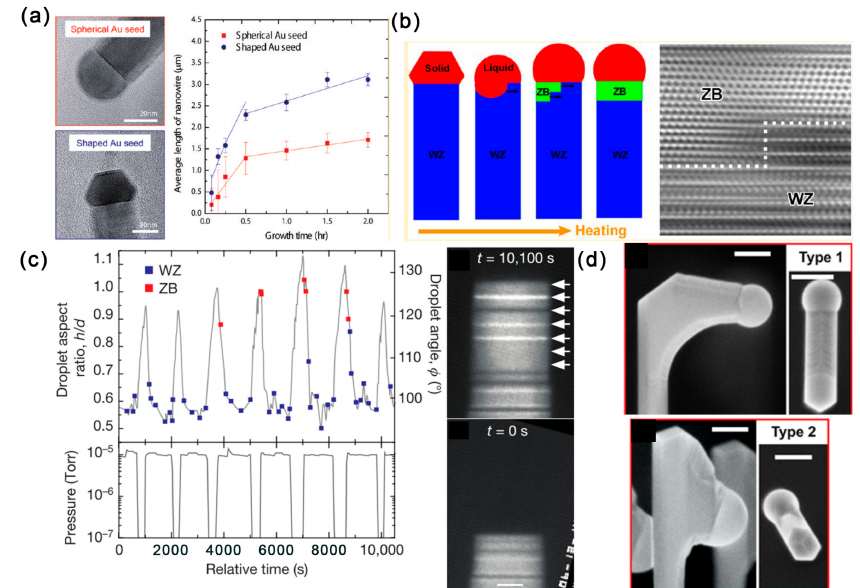
Figure 6. Influence of droplet NPs on the growth of III–V NWs. ( a ) Relationship between the average length and growth time of InAs NWs grown with spherical and shaped Au seed particles. Reproduced with permission [67]. Copyright 2012, American Chemical Society. ( b ) Role of Au particles in tailoring the nucleation and phases of InAs NWs at the liquid/solid interface. Reproduced with permission [68]. Copyright 2013, American Chemical Society. ( c ) Growth of a WZ GaAs NW containing multiple narrow ZB by controlling the AsH 3 pressure and the droplet morphology. Reproduced with permission [69]. Copyright 2016, Macmillan Publishers Limited. ( d ) Side- and top- view images of type 1 horizontal and type 2 downward-grown self-catalyzed GaAs NWs. Reproduced with permission [70]. Copyright 2019, American Chemical